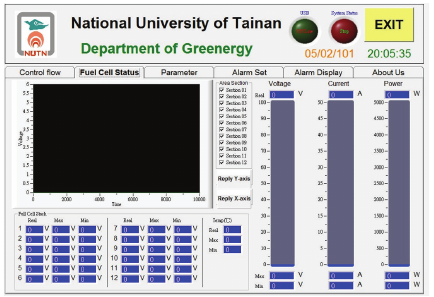
Figure 8: Subscreen showing fuel cell status details.